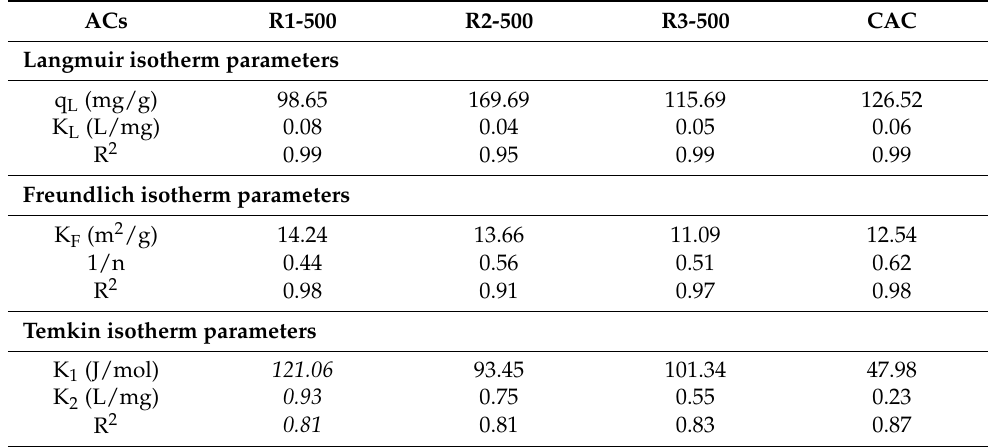
Table 5. Langmuir, Freundlich, and Temkin adsorption parameters obtained from equilibrium isotherms of atenolol for the activated carbons.